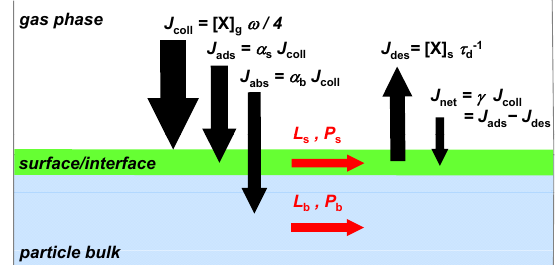
Fig. 1. Schematic illustration of key processes and flux terms de- scribing gas uptake by atmospheric particles: gas kinetic flux of surface collisions ( J coll ), the adsorption onto the particle surface ( J ads ), absorption into the particle bulk ( J abs ), desorption from the surface ( J des ), and net uptake by the condensed phase ( J net ). The red arrows indicate production and loss of chemical species by re- actions at the particle surface ( P s , L s ) or in the particle bulk ( P b , L b ). [X] g and [X] s stand for the gas and surface concentrations of volatile species X; ω is the mean free path of X in the gas phase; α s and α b are the surface and bulk accommodation coefficients; τ d is the desorption lifetime, and γ is the net uptake coefficient (P¨oschl et al.,